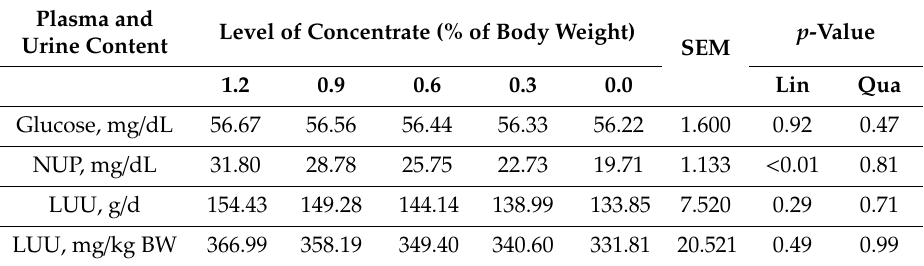
Table 3. Glucose and urea levels in blood plasma and loss of urinary nitrogen of Pantaneira cow breed, fed with di ff erent levels of